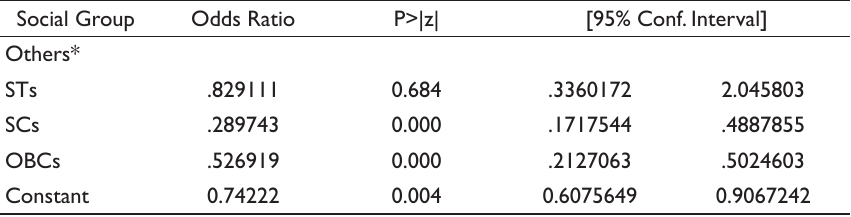
Table 6. Logistic regression model for social groups in Delhi